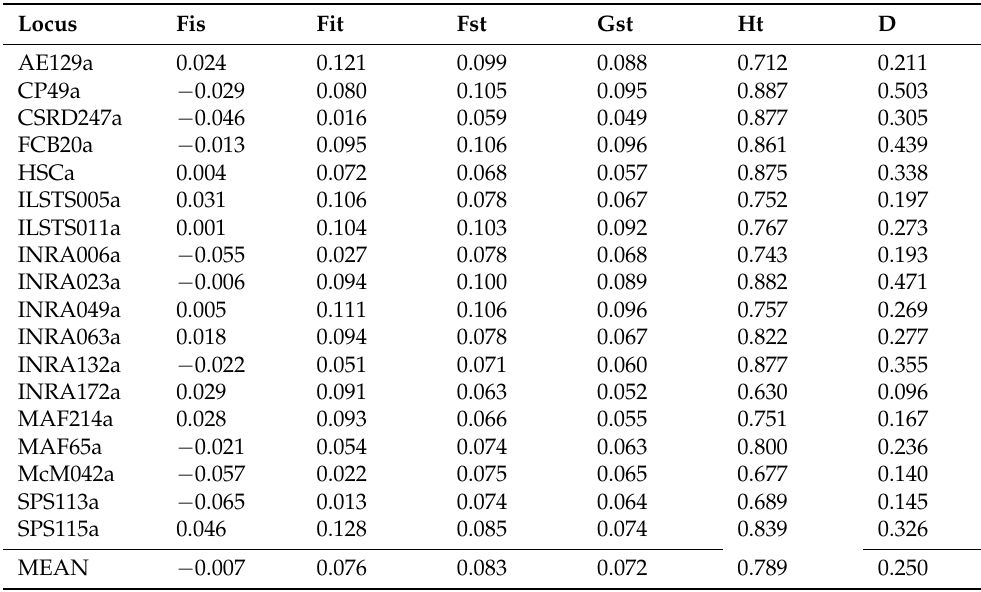
Table 4. Fixation index (Fis, Fit, Fst), genetic diversity among populations at each locus (G ST ), total expected heterozygosity (Ht), and Jost’s estimate of differentiation (D). Locus